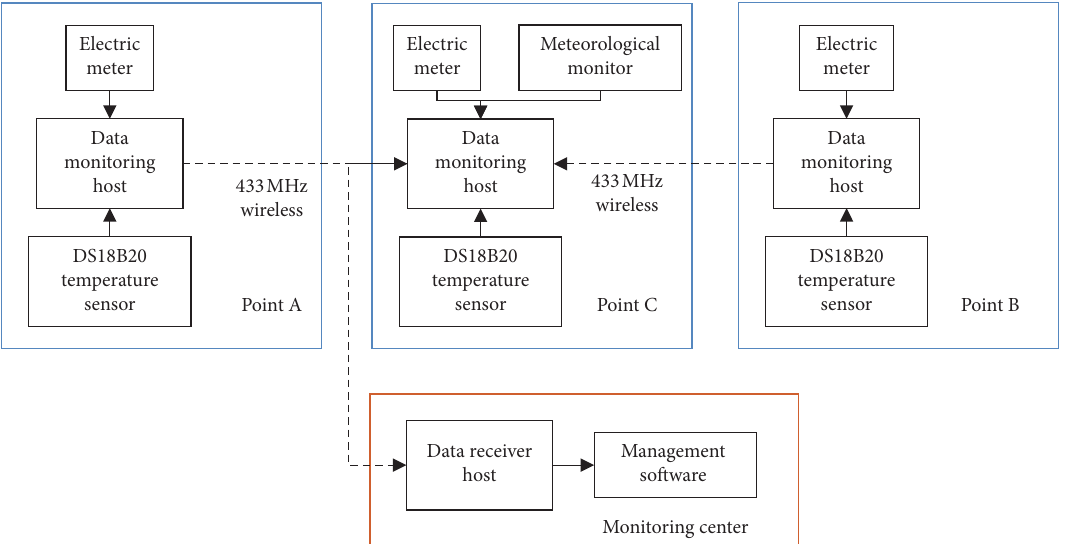
Figure 1: The structure of the MSIF monitoring system.